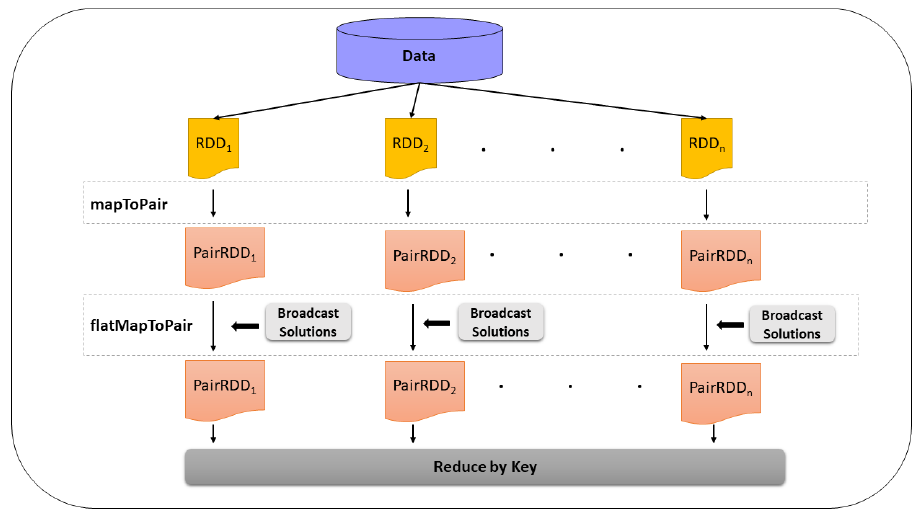
Figure 2. The fitness evaluation